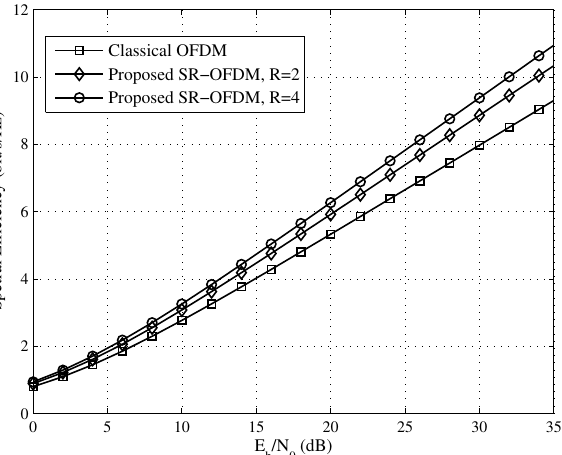
Figure 8. Spectral efficiency comparison between the SR-OFDM and OFDM under an AWGN